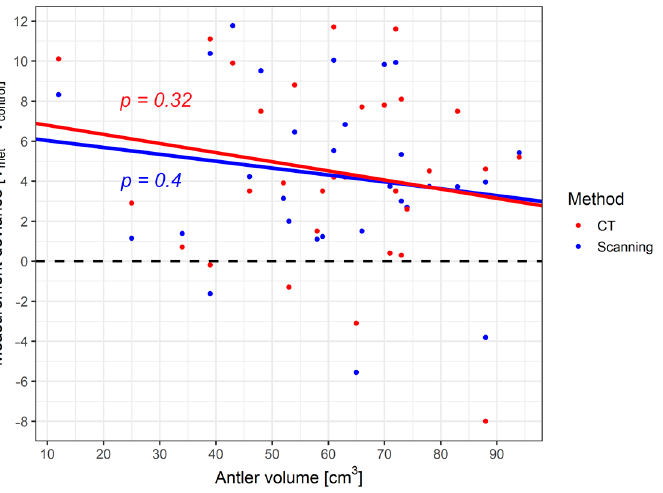
Figure 7. Dependence of deviations of antler volume measurements by the investigated methods on the actual antler volume. R-squared values: Scanner—0.025, CT—0.036. The displayed p -values apply to the null hypothesis of a slope of the linear regression line equal to 0.